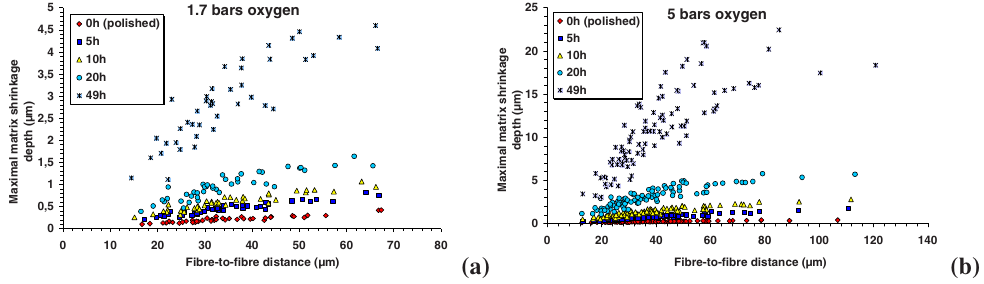
Fig. 6. CIM measurements on samples aged isothermally at 150°C under 1.7 bars and 5 bars of oxygen: 5h, 10h, 20h, 49h